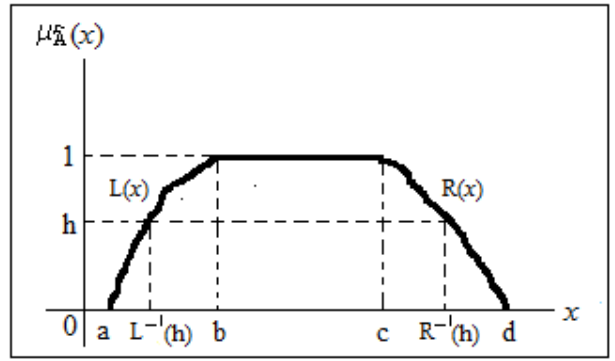
Fig. 3. The graded mean h-level value of generalized fuzzy number